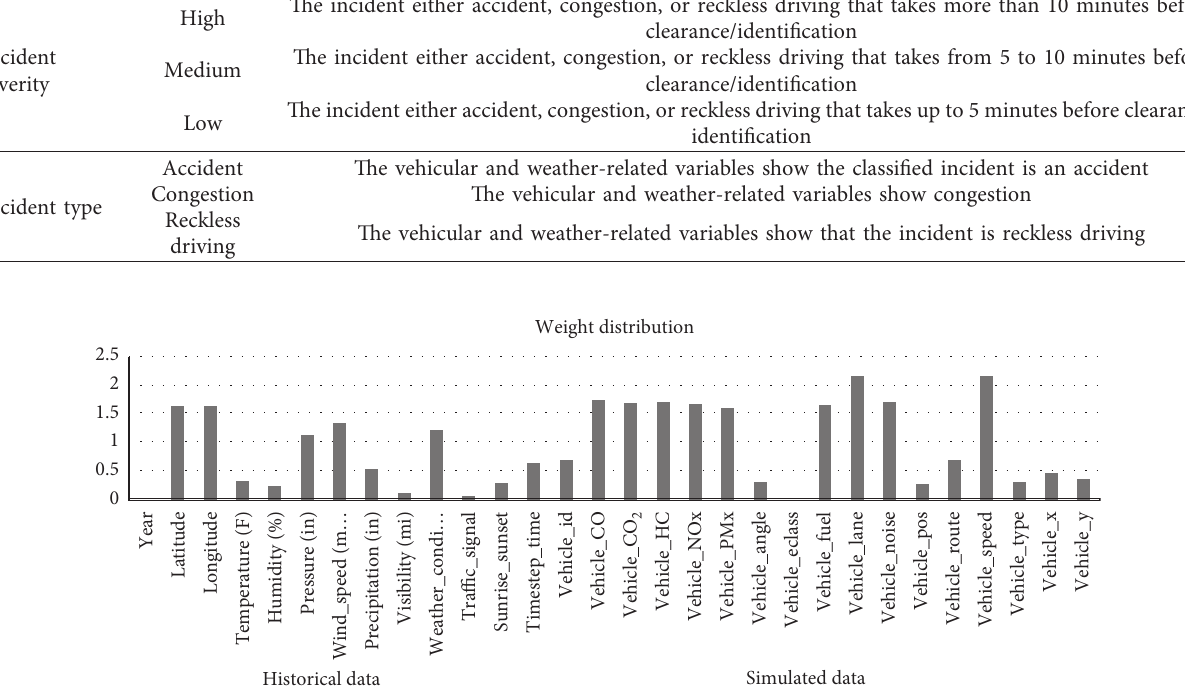
Figure 4: Feature weight distribution in case of incident severity classification.